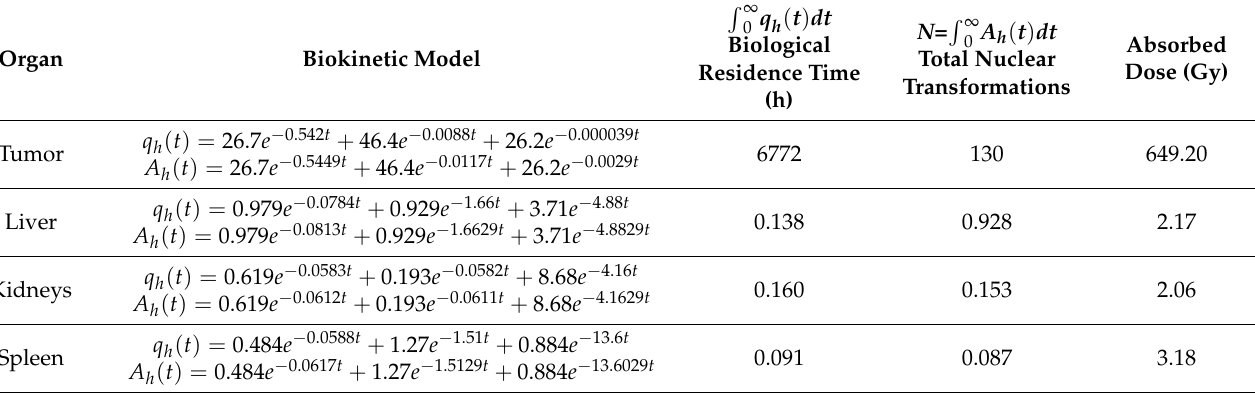
Table 4. Biokinetic models and average radiation-absorbed doses in different tissues (liver, kidney, spleen, and HEP-G2 tumor) of mice intratumorally injected with 225 Ac-rHDL (1